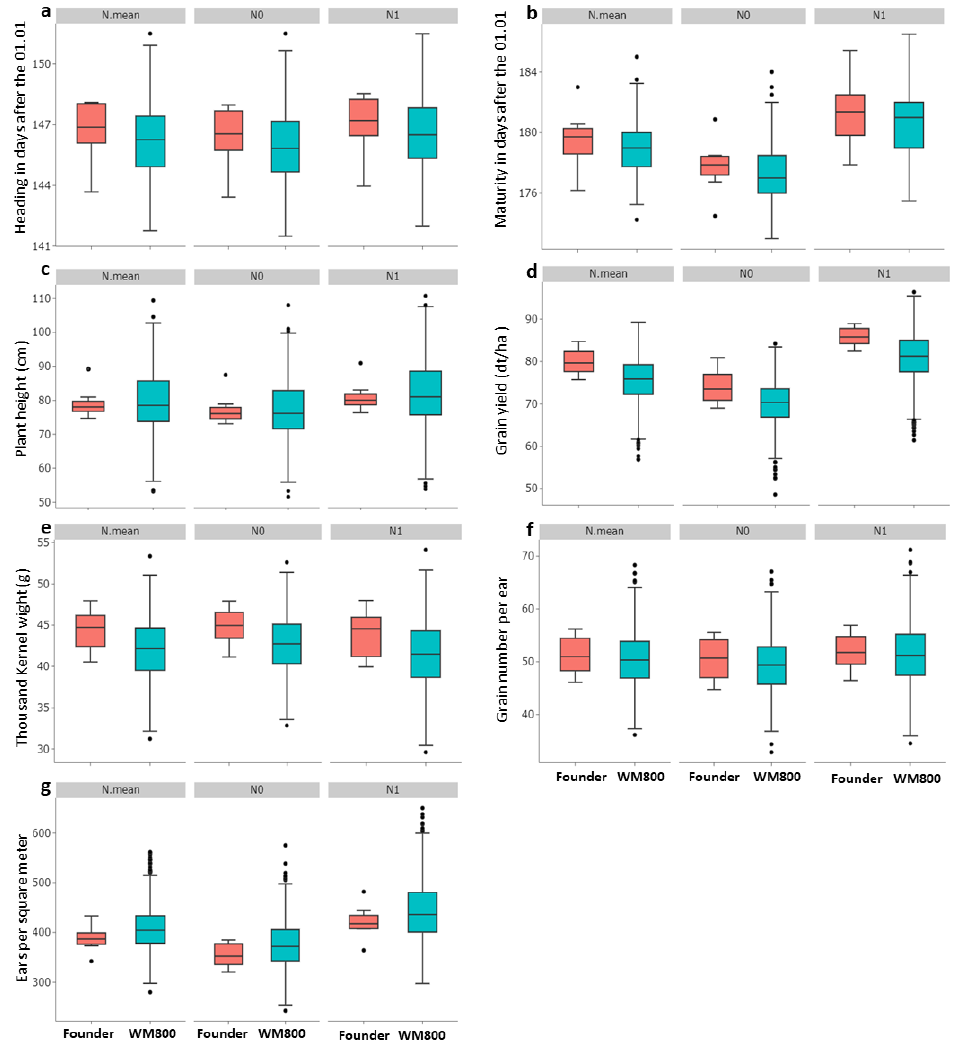
Figure 1. Box-Whisker-Plots indicating variations among WM-800 lines and founders across (N.mean) and within N treatments (N0 and N1) for seven traits studied (subplots ( a – g )). For all traits, the ANOVA indicated highly significant differences between N treatments at p < 0.001 or p < 0.01 for both population WM-800 and the founders.